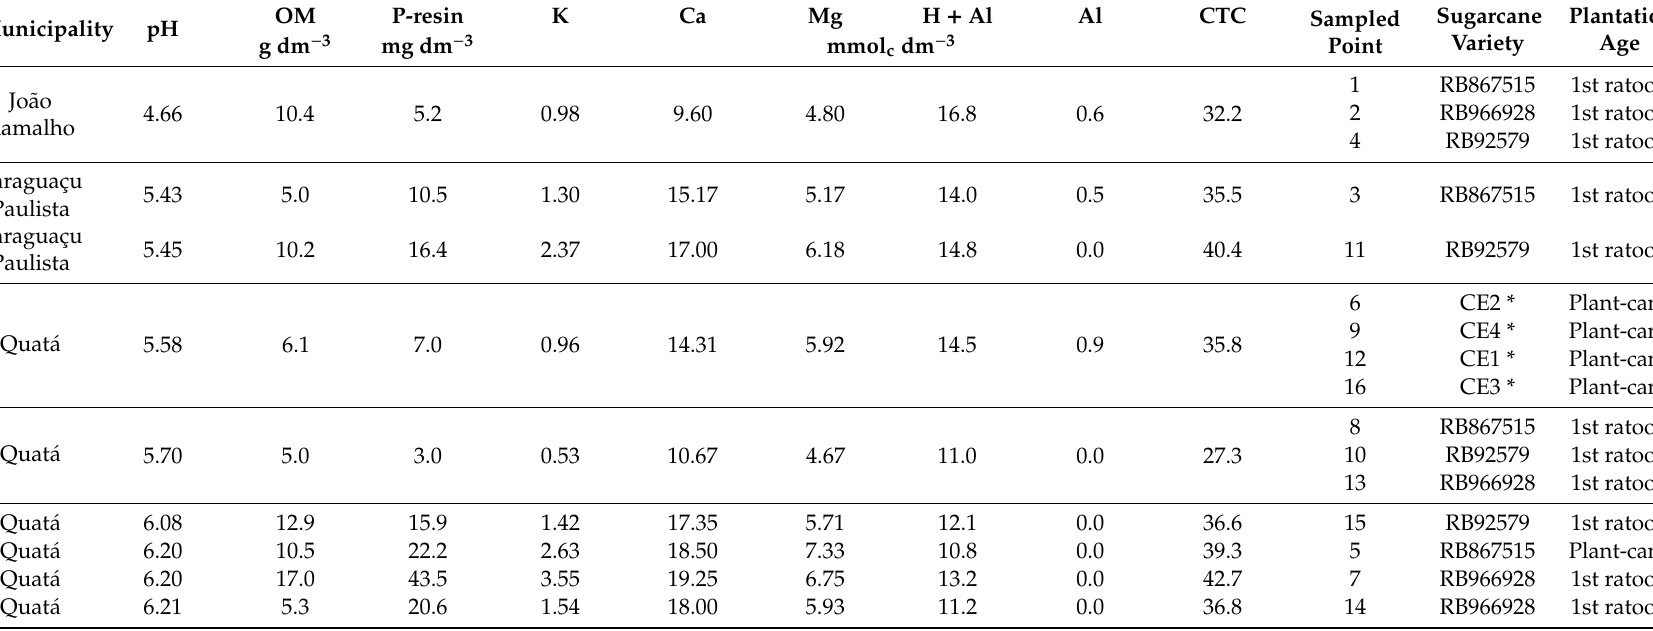
Sugarcane Plantation Variety Point